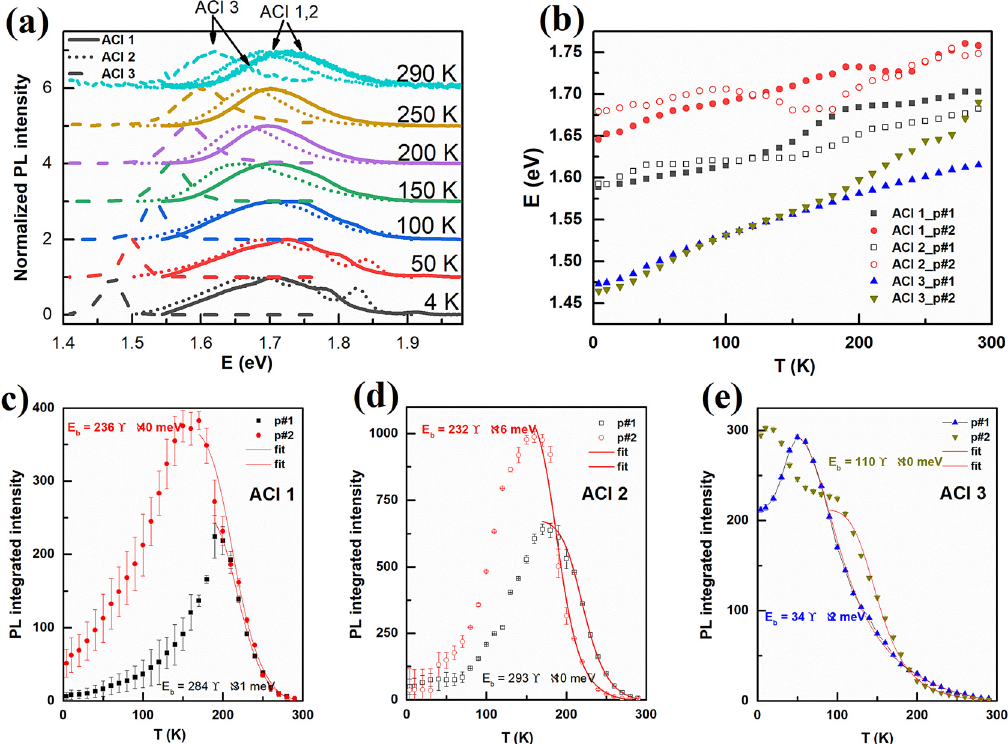
Figure 3: Temperature evolution of the PL properties of ACI 1, 2, and 3. (a) PL spectra at different temperatures for ACI 1, 2, and 3. The two peaks (annotated as p#1 and p#2) indicated by arrows for n = 1, 2 and for n =3areconsideredforfurtheranalysis,(b)temperaturedependenceofthePLpeakcentersofthepeaksindicatedbyarrowsin(a)forallthree materials, (c – e) PL integrated intensity as a function of temperature ( T ) for ACI 1 (c), ACI 2 (d) and ACI 3 (e). The exciton binding energies are extracted using the Arrhenius equation shown by solid lines in Figure (c –